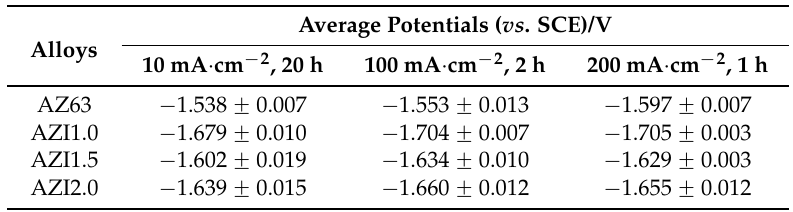
Table 4. Average discharge potentials of AZ63 and AZI alloys under different conditions.